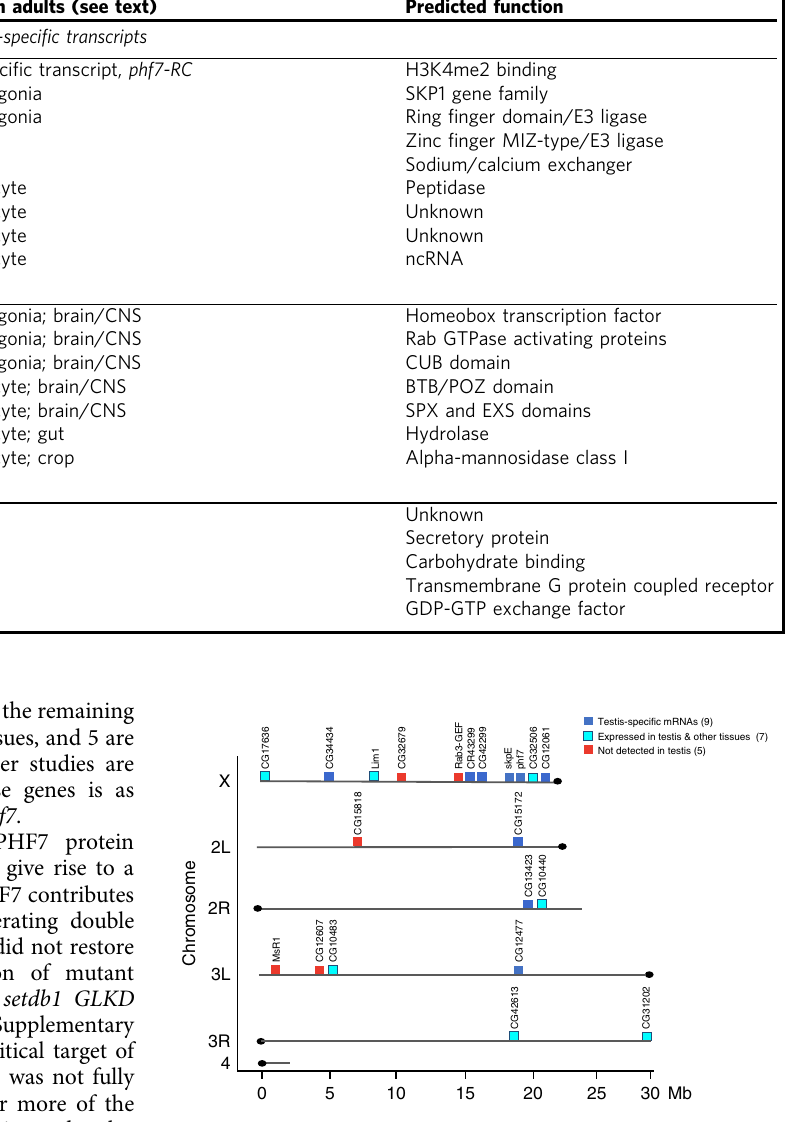
Fig. 5 Distribution of the 21 SETDB1/H3K9me3 regulated genes in the genome. The 21 genes are not clustered together in the genome. Gene positions are shown on the six major chromosome arms. Chromosome length is indicated in megabase pairs (Mb). See Supplementary Table 1 for the exact position of each gene. The normal expression pattern of these genes is indicated as follows: genes with testis-speci fi c isoform (dark blue), genes expressed in testis and other tissues (turquoise) and genes not normally expressed in adult testis (red). See Table 1 for